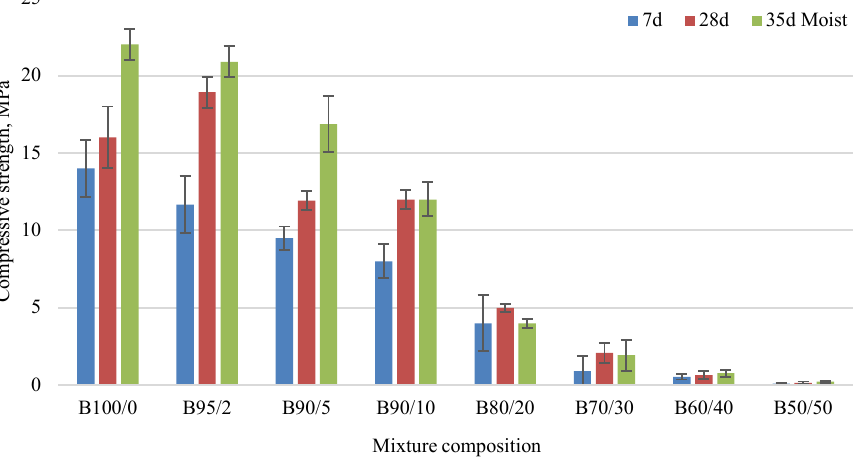
Fig. 10. Mixture composition of ground brick and different amount of silica gel AAM activated with 6 M